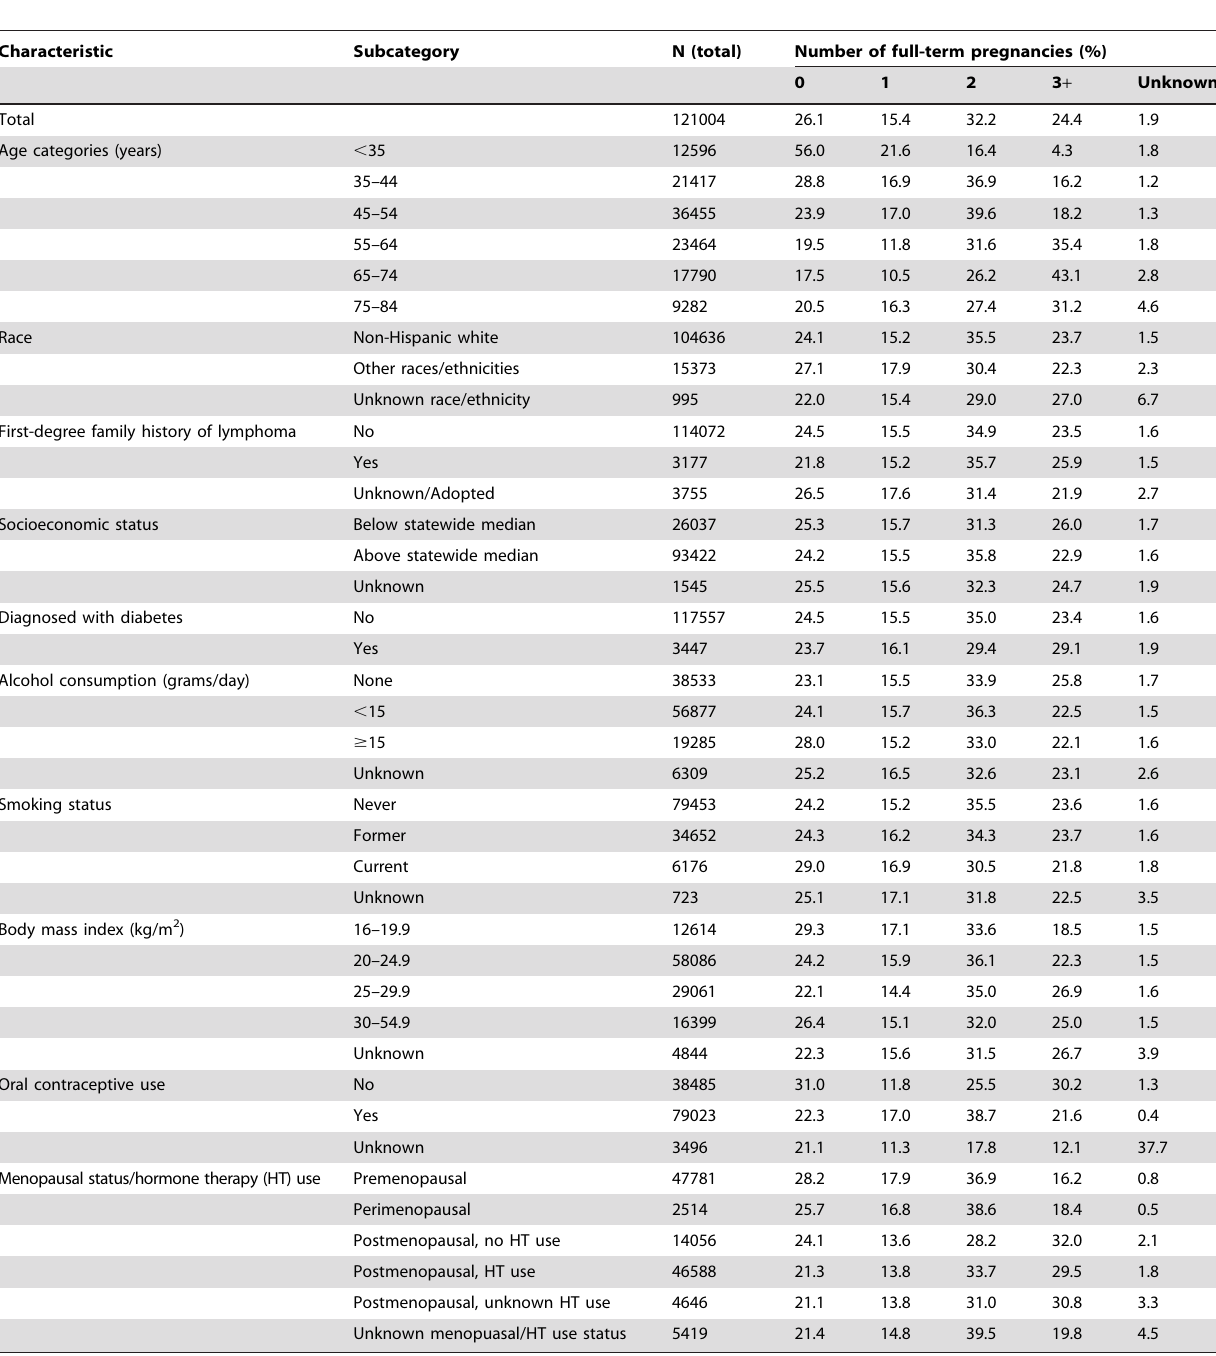
Table 1. Selected baseline characteristics of 121,004 eligible women in the California Teachers Study by number of full-term pregnancies at